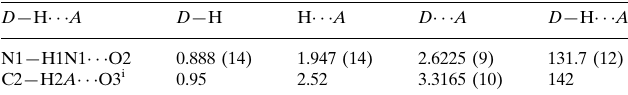
Hydrogen-bond geometry (A˚ , (cid:2)